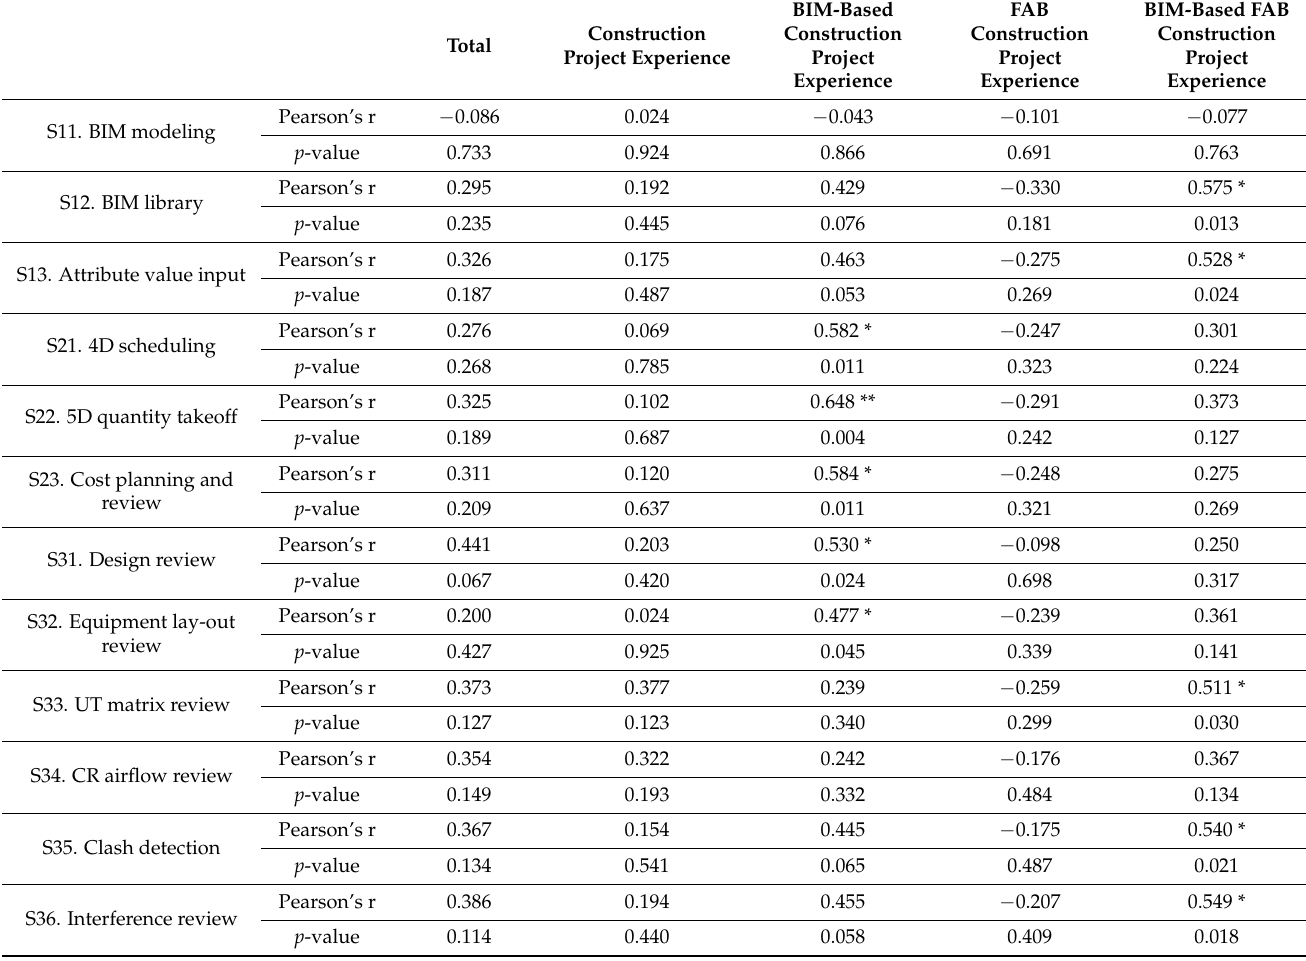
Table 9. Analysis of correlation between ‘Skills’ domain competencies and career characteristics of the owner